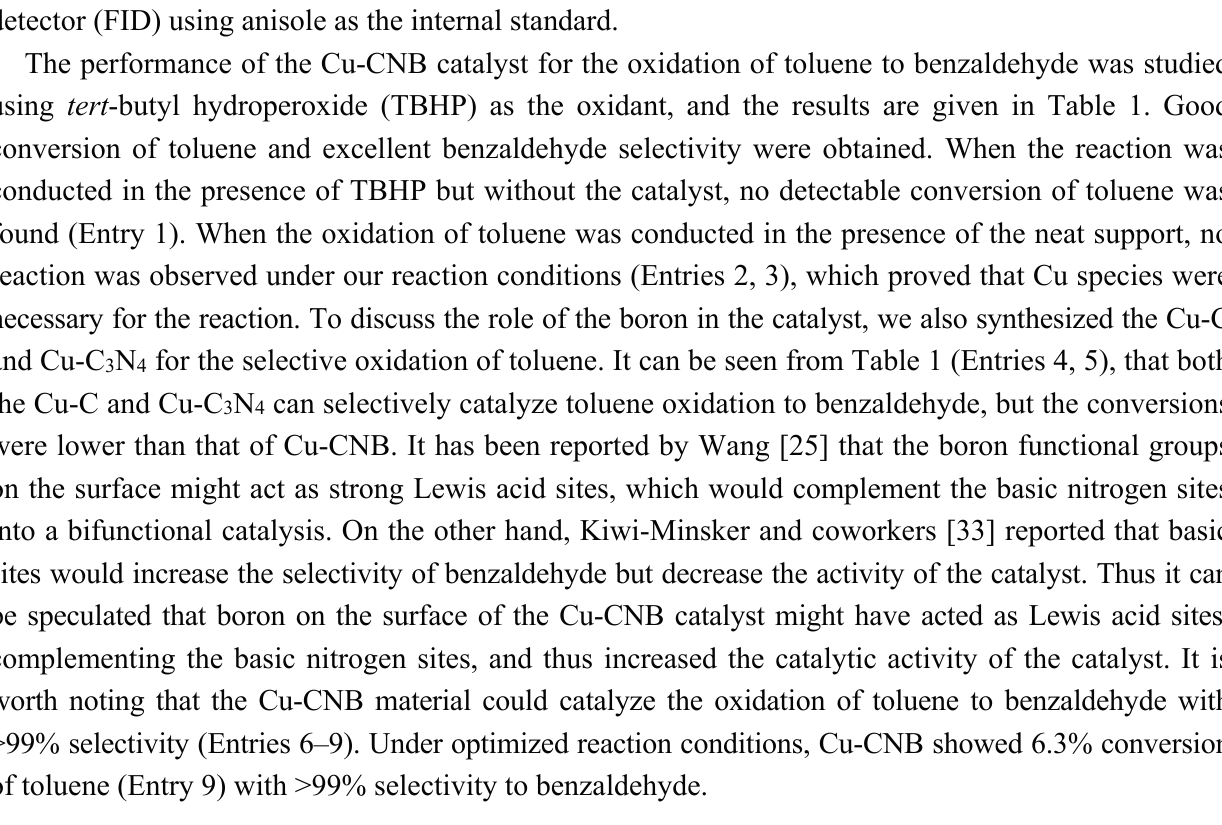
Table 1. Selective oxidation of toluene on Cu and boron doped graphitic carbon nitride catalyst (Cu-CNB) with tert-butyl hydroperoxide (TBHP) as oxidant a .